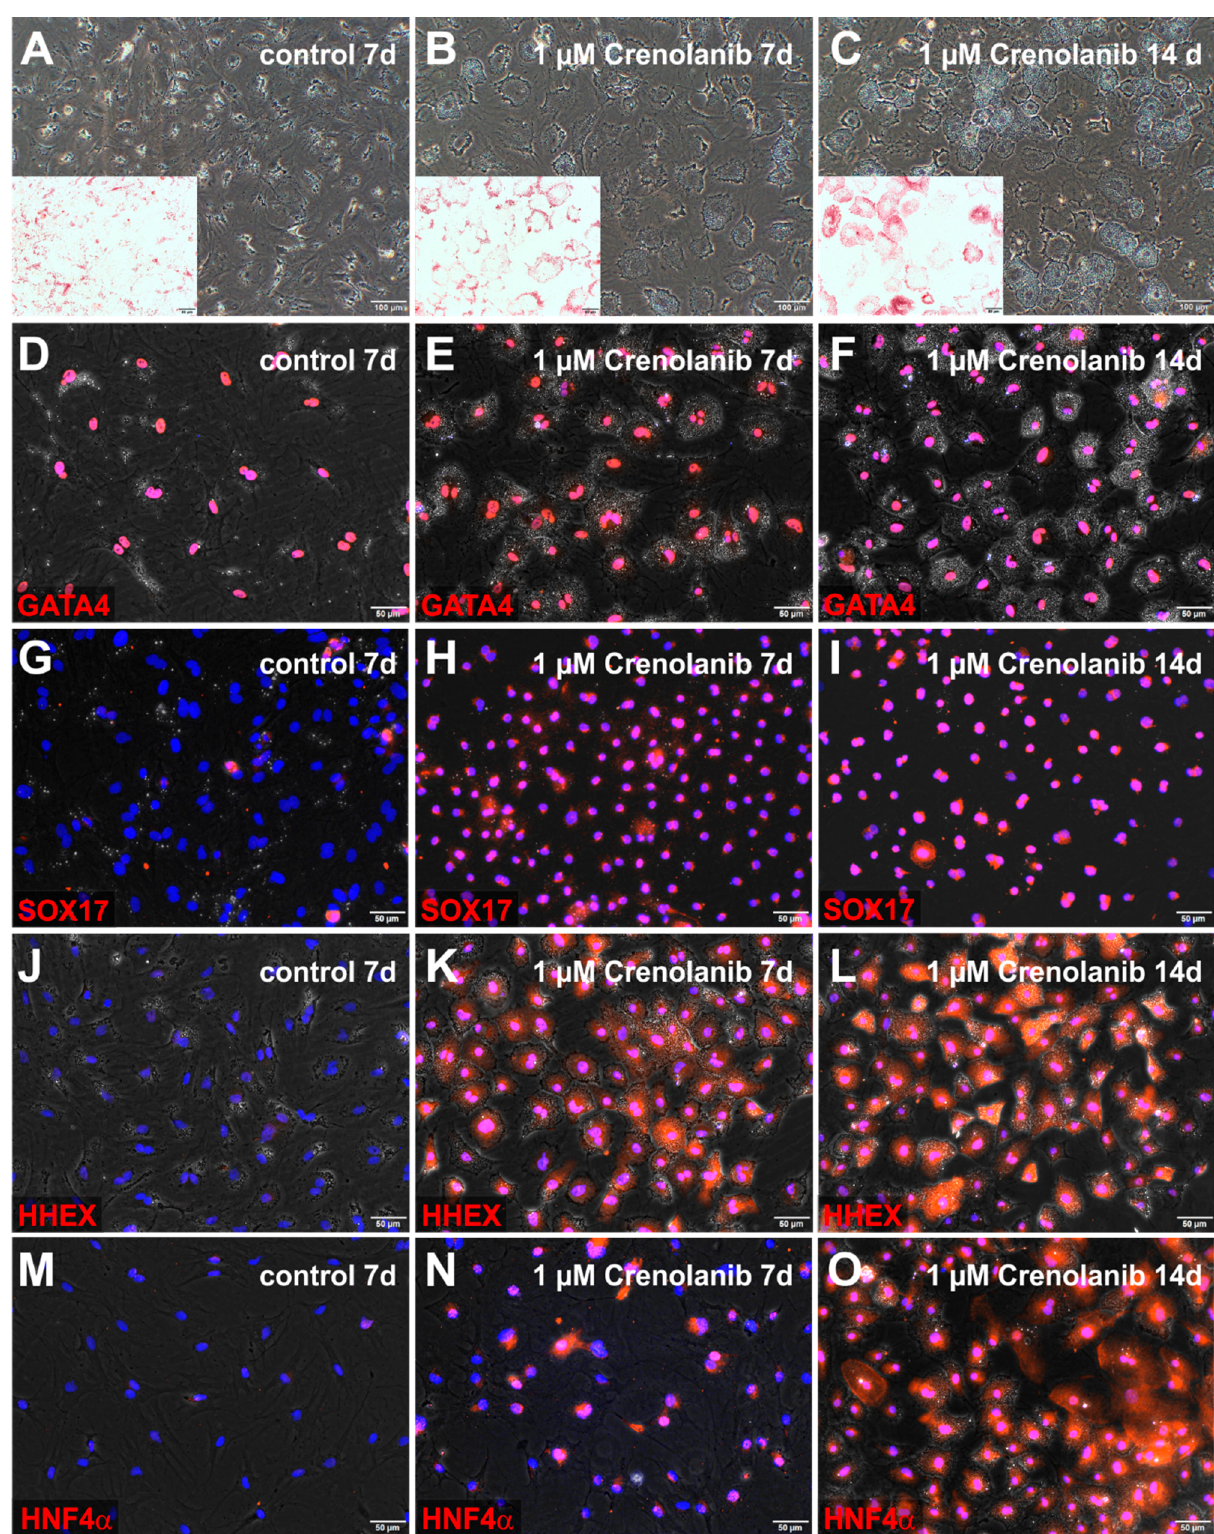
Figure 4. Crenolanib-induced endodermal markers in isolated rat HSC. HSC were cultured ( A ) without (control) and ( B and C ) with 1 µM Crenolanib for 7 to 14 days, using serum-free culture medium. In the presence of Crenolanib, the cells lost their myofibroblast-like cell morphology, became polygonal, and accumulated lipids, as determined by Oil-Red-O staining (red, inserts). ( D–O ) Immunofluorescence of GATA binding protein 4 (GATA4), SRY-box transcription factor 17 (SOX17), hematopoietically-expressed homeobox protein (HHEX), and hepatocyte nuclear factor 4 α (HNF4 α ) in control and Crenolanib-treated HSC. ( D–F ) GATA4 (red) was always found in the cell nuclei of HSC, irrespective of treatment conditions. ( G–I ) SOX17 (red) was detectable in the cell nuclei of all HSC treated with Crenolanib, whereas SOX17 was